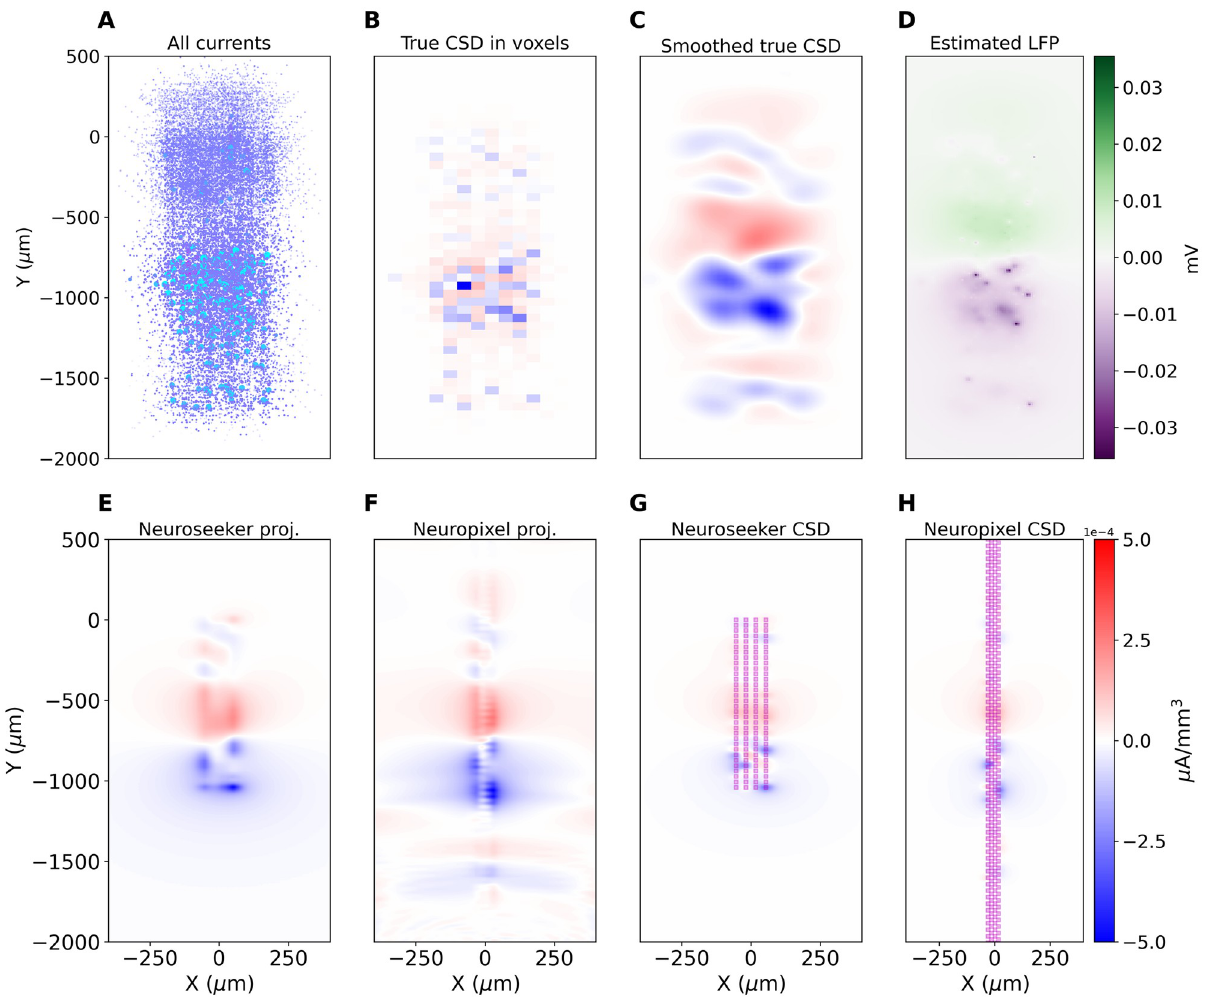
Fig 2. Validation of kCSD on data from simulated cortical recordings of whisker deflection in Traub’s model. (A) Colored dots indicate positions of simulated cell segments within a slice of 100 μm width passing through the center of the simulated barrel column. The color encodes the value of transmembrane currents. (B) True CSD computed in voxels of 50 μm side, slice passing through the column center. (C) True CSD smoothed with a Gaussian kernel. (D) Extracellular potential computed from the whole column in the place passing through the center of the column. (E) and (F): Projections of C on the space of eigensources defined by setups shown in (G) and (H). (G, H) CSD estimated with kCSD with cross-validation from simulated measurements with a single electrode block of a Neuroseeker (E) and a single bank of Neuropixels (F) probes. Magenta squares indicate the positions of electrode